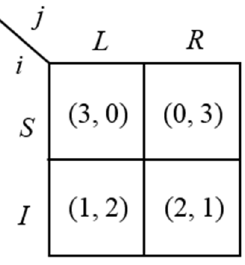
Figure 3. Original game G with no equilibrium confirmed